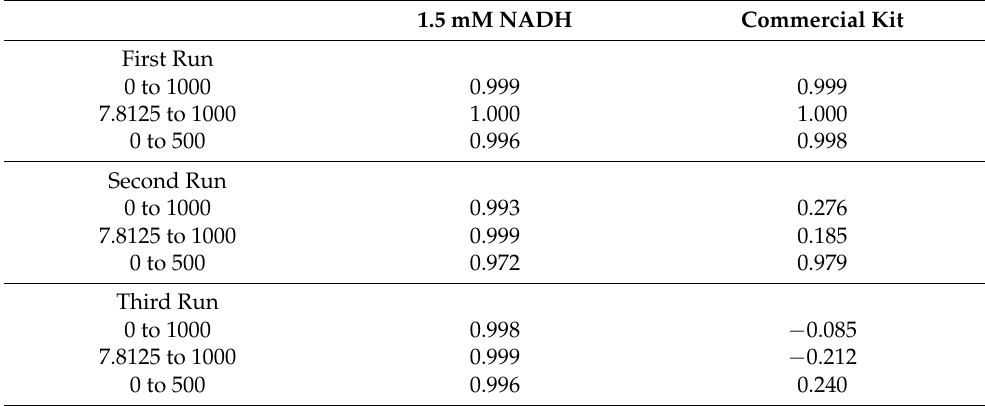
Table 2. Correlation coefficients between ALT [U/L] and maximum reaction velocity [milliunits/min] in comparison with commercial Kit.